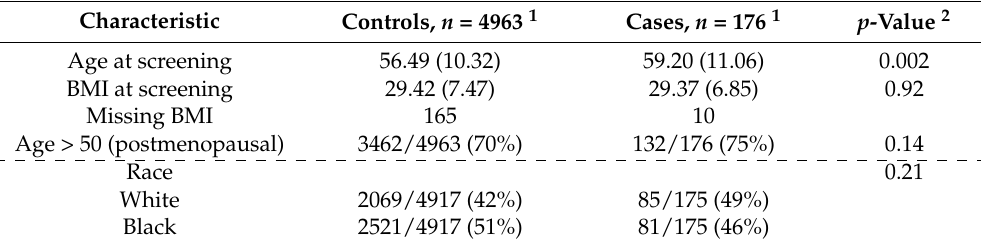
Table 1. Baseline characteristics of study dataset by case–control status.